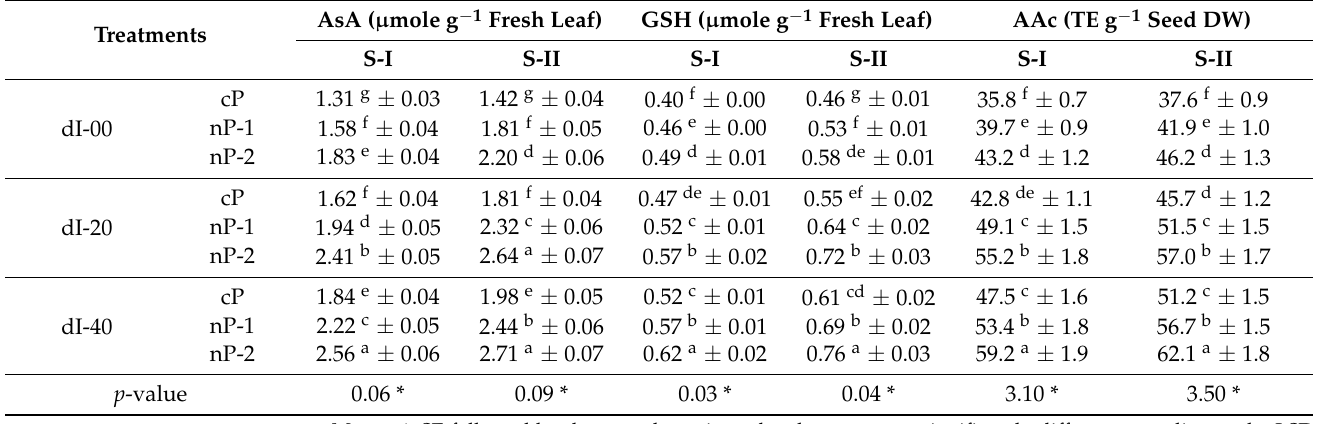
Table 7. The contents of ascorbate (AsA), glutathione (GSH), and antioxidative activity (AAc) in leaves of fenugreek plants as affected by different irrigation water regimes and soil and foliar nourishing with phosphorus (P) during two growing seasons.